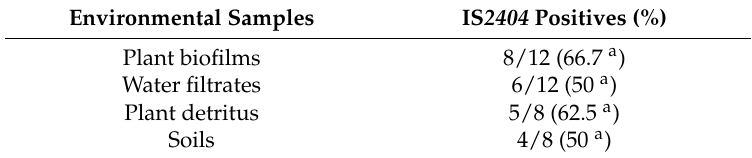
Table 3. Distribution of IS 2404 positive mycolactone producing mycobacteria in aquatic environmental matrices from